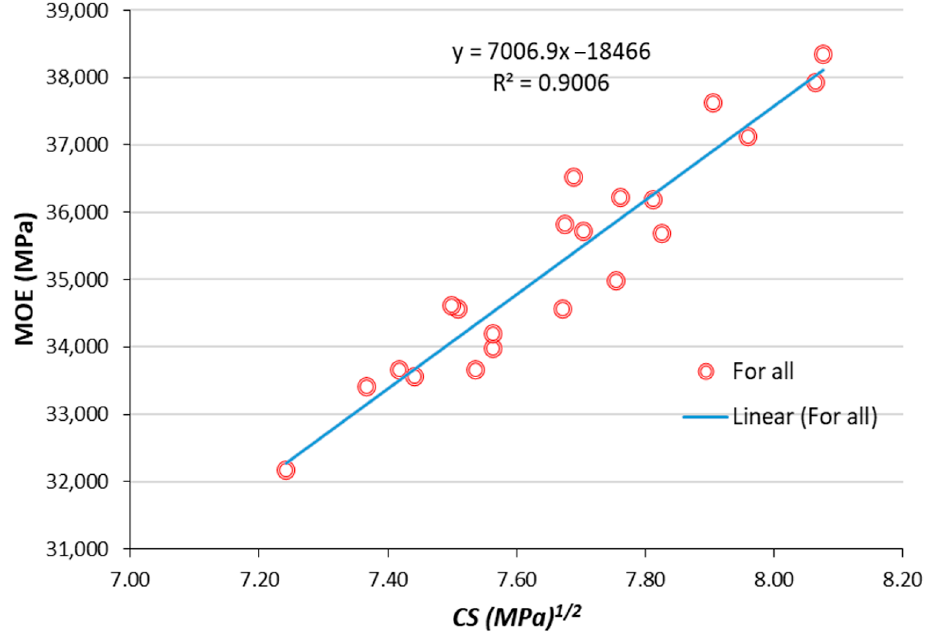
Figure 7. Relationship between MOE and CS 1/2 .